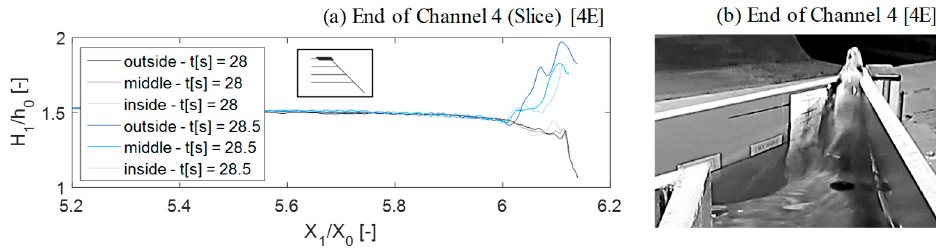
Figure 7. Slice of channel 4 ( a ) at the outside, middle and inside, for the time step 28 s and 28.5 s and photo of the end of channel 4 ( b ) for the time step 28.5 s in the physical model.